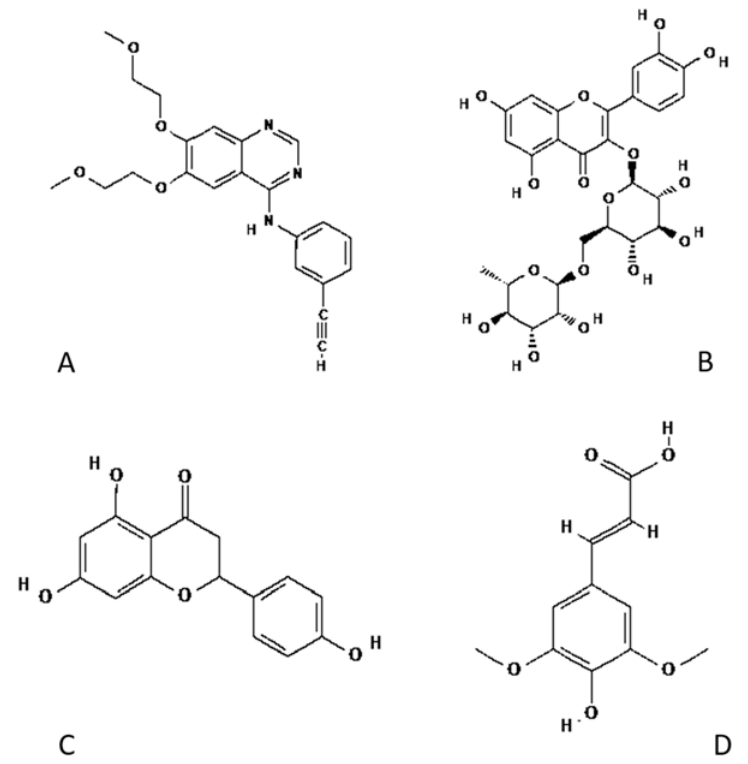
Figure 1. The chemical structures of ( A ): ETB; ( B ): RUT; ( C ): NAR; ( D ):